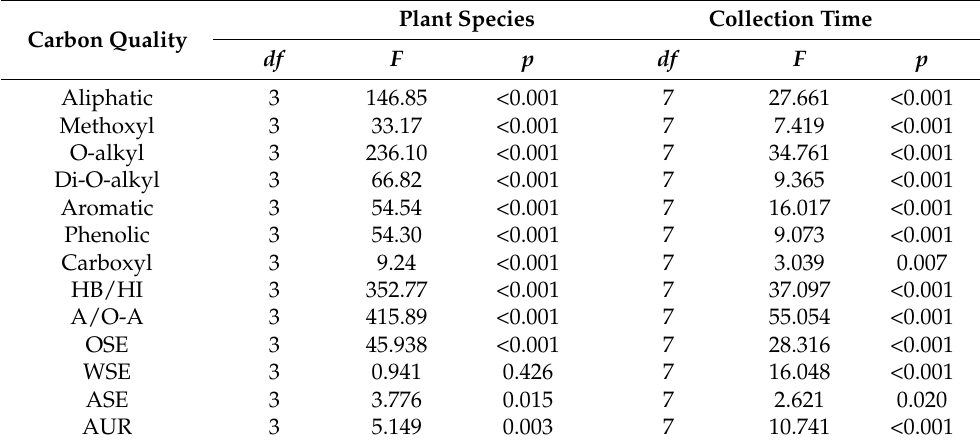
Table 2. Results of two-way ANOVA testing for the effects of the collection time (from August 2015 to July 2016) and plant species on the C quality of newly shed foliar litter (plant species: fir, spruce, willow and rosa; functional C groups: aliphatic C, methoxyl C, O-alkyl C, di-O-alkyl C, aromatic C, phenolic C and carboxyl C; organic components: WSE, water-soluble extractives, OSE, organic-soluble extractives, ASE, acid-soluble extractives, AUR, acid-unhydrolyzable residues; HB/HI, (0–45 ppm + 110–165 ppm)/(45–110 ppm + 165–190 ppm), and A/O-A, aliphatic C/O-alkyl C)). Carbon